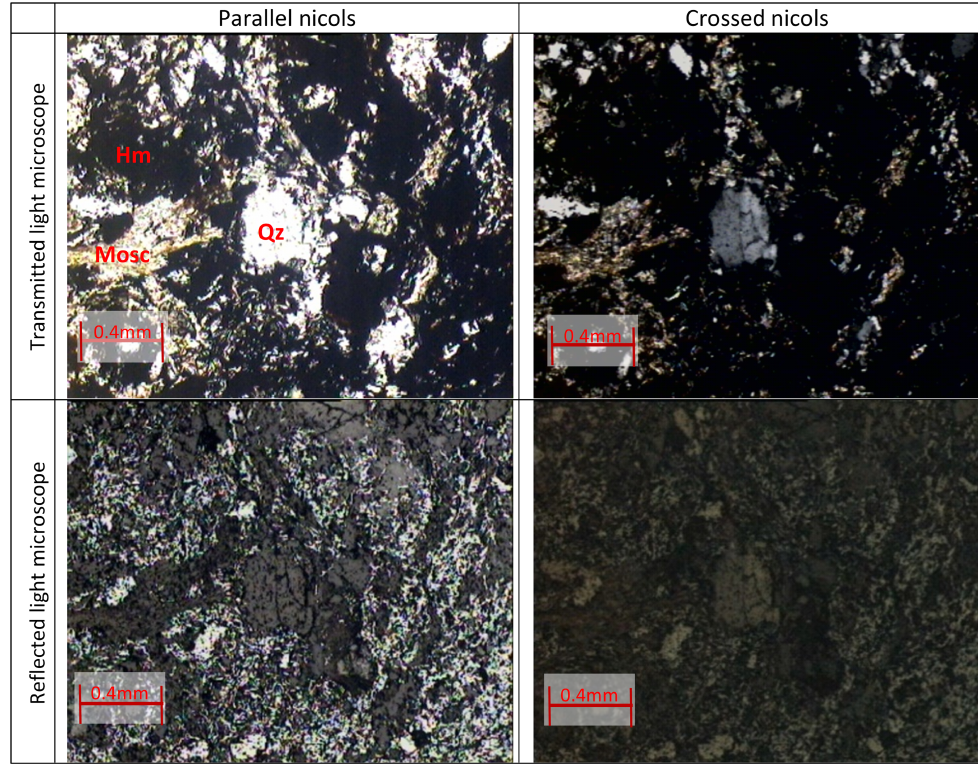
Figure 5. Observation of the polished surface under the microscope with transmitted and reflected light, in parallel and crossed niches. A matrix of hematite (small-grained) is observed, containing quartz and muscovite. The amount of hematite is about twice that of